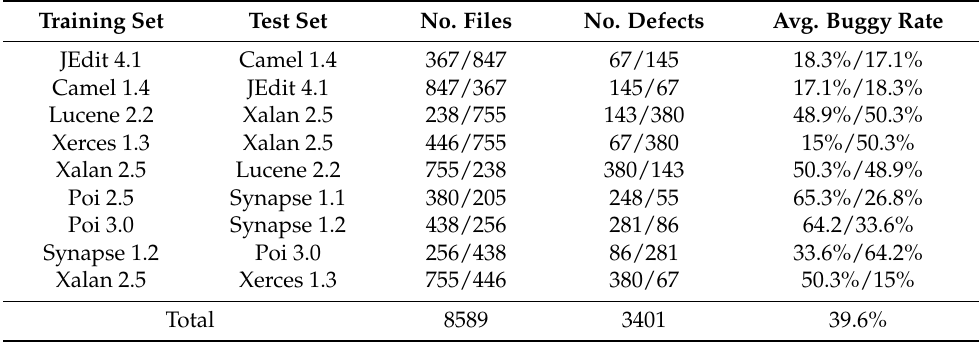
Table 2. CPPSC dataset description. The number of files, number of defects, and average buggy rate are listed separately for the training set and the test